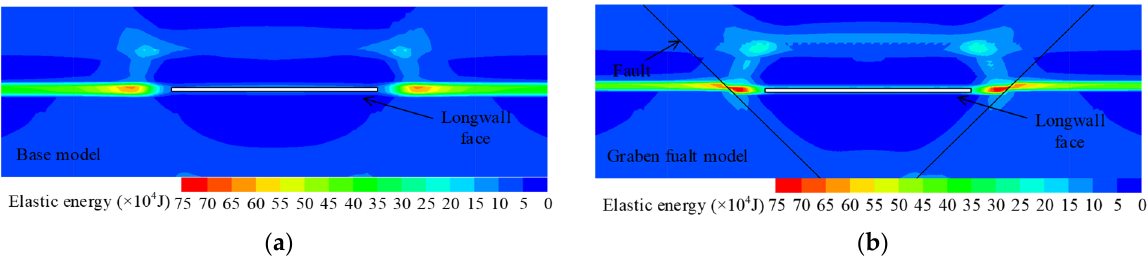
Figure 7. Elastic energy distribution contour (cross-section of 30 m behind the longwall face). ( a ) Base model; ( b ) Graben fault model.